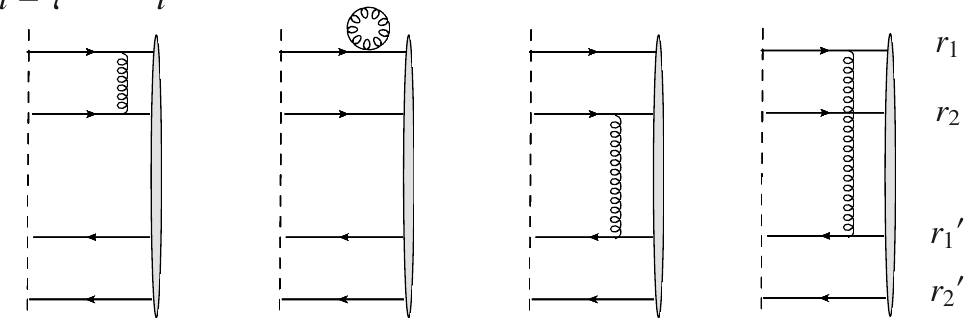
Figure 6 . Graphical illustrations for typical contributions to the operators L i for the two-particle density matrix. In the (cid:12)rst two diagrams, the gluon line represents either V or W , while in the last two, only W and its spatial derivatives are involved (the hamiltonian evolution, involving the real part of the potential, does not connect the upper and lower parts of the diagrams). In the last diagram, the gluon line connects two particles with the same charge, and contribute to the quantity called W a . In the third diagram, the gluon line connects two particles with opposite charges, and contributes to the quantity called W a . When W is involved in the (cid:12)rst diagram, it represents a contribution to W c , and (cid:12)nally the tadpole insertion in the second diagram is associated to V (0), or to W (0) and its spatial drivatives. The de(cid:12)itions of W a;b;c are given in eq.